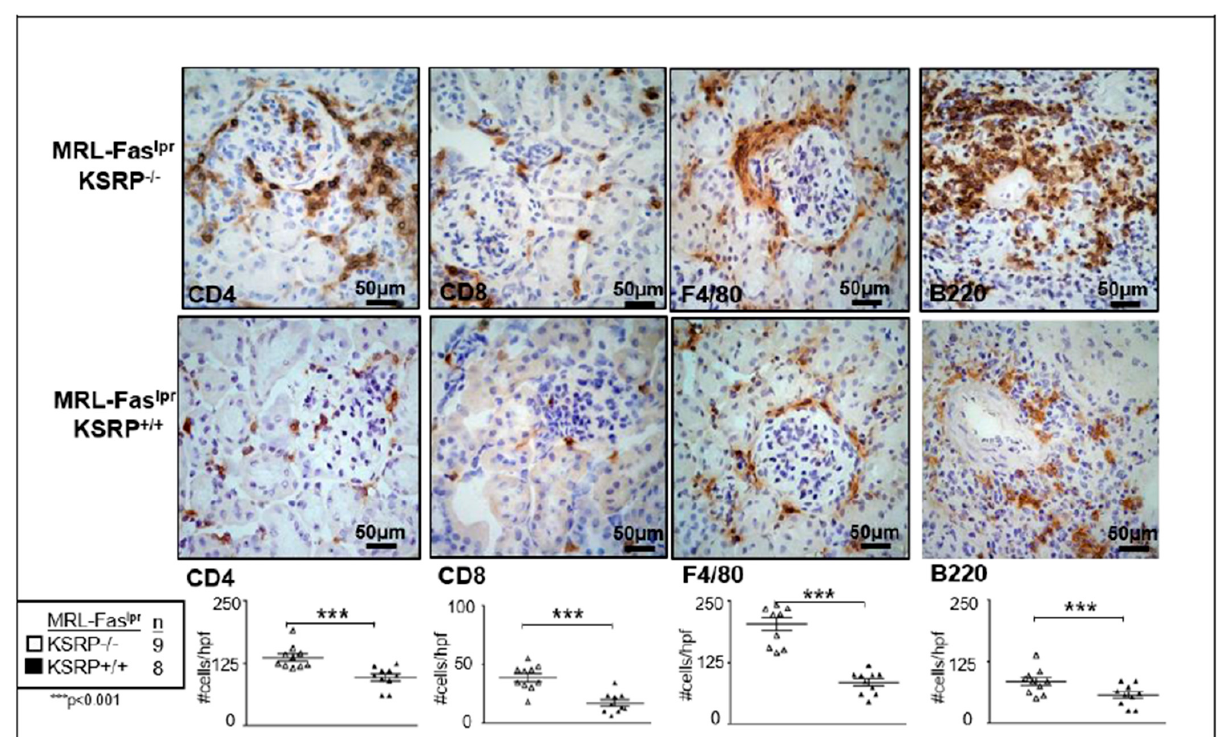
Figure 2. Frequencies of intra-renal CD4, CD8, F4/80 and B220 positive cells in the kidneys of 19-week-old female MRL- Fas lpr KSRP − / − mice compared to MRL-Fas lpr KSRP +/+ mice Immunostaining was used to analyze intra-renal frequency of CD4, CD8, F4/80 and B220 positive cells in the kidneys of female 19-week-old MRL-Fas lpr KSRP +/+ and MRL-Fas lpr KSRP − / − mice. Data presented are the mean + SEM of the score with 8 to 12 animals per genotype (*** p < 0.001 compared to WT, t - test). Representative image of immunostaining with 40× magnification.